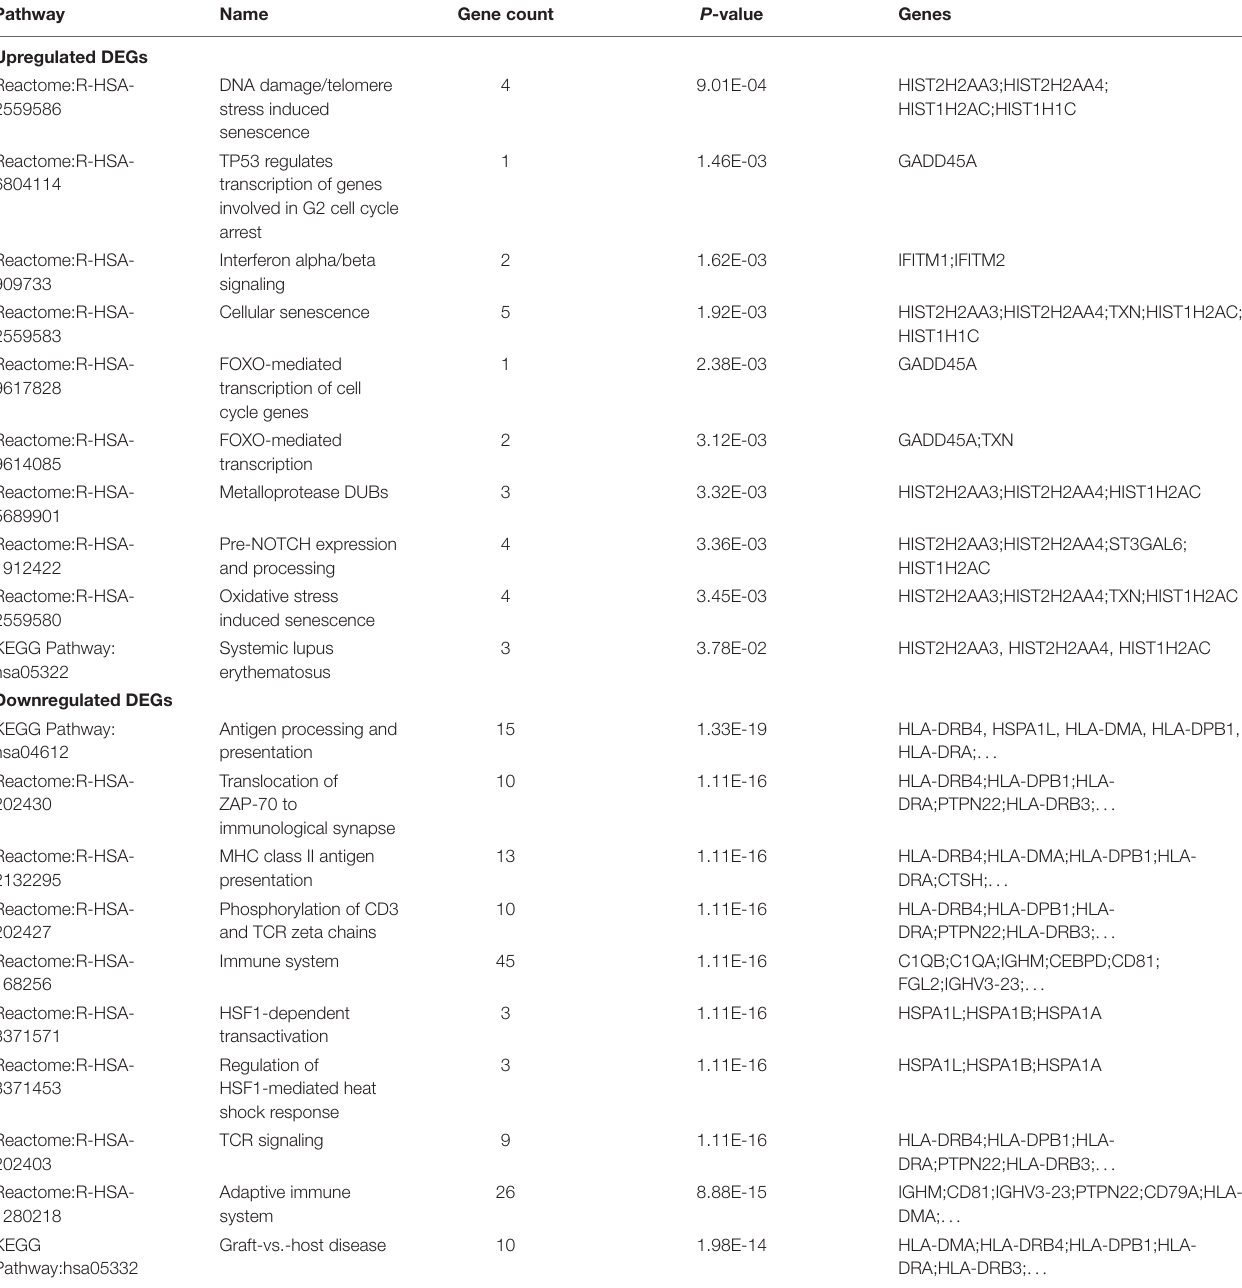
TABLE 2 | Signaling pathway enrichment analysis of DEGs in multiple myeloma. Pathway Name Gene count P -value